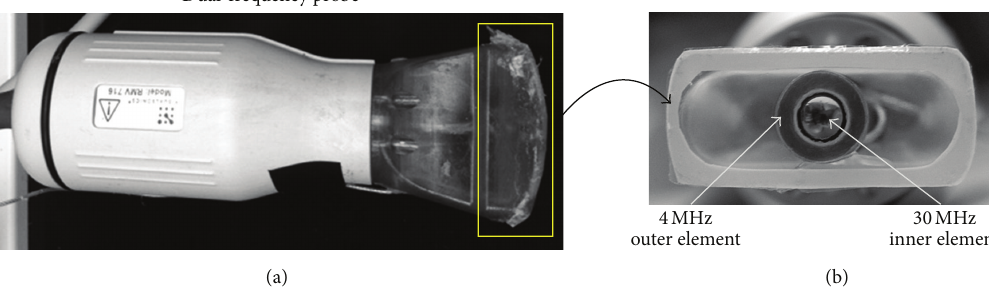
Figure 1:Photograph of thedual-frequency probe, illustratingthesideview (a)and thebottom view (b)showing thetwo transducerelements. The probe housing is a modified VisualSonics “RMV” transducer